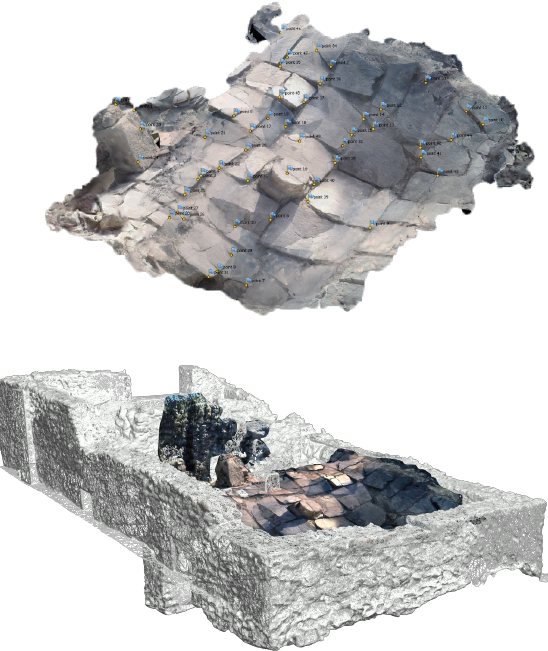
Figure 9: Top: 3D model of the excavated floor surface of Room 2 in Complex Beta generated through image-based modelling from photos taken in 1969, with the used tie points marked. This sur- face had been removed during the excavation process. Bottom: The reconstructed floor surface placed inside the 3D model of Room 2 of Complex